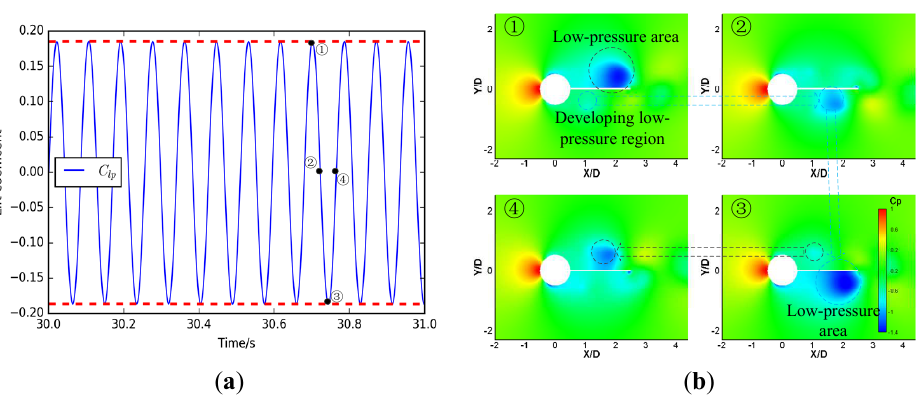
Figure 8. ( a ) Instantaneous lift ( C lp is the lift coefficient on the plate) and ( b ) pressure-coefficient contours around the splitter with U = 2 m/s and L ∗ =